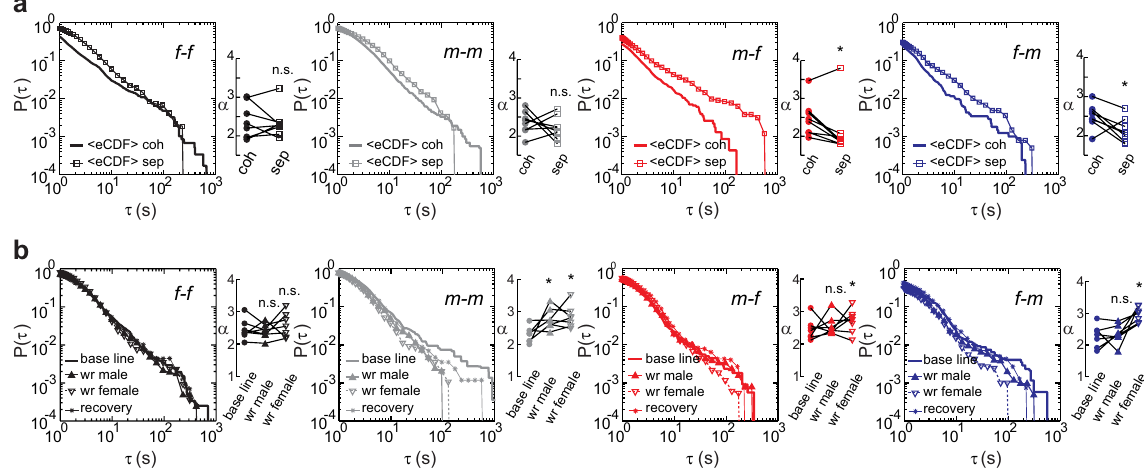
Figure 4. The exponents of different callings changed transiently in response to the social context ( a ) and the access to water ( b ). ( a ) Comparison of median empirical cumulative distribution functions ( < eCDF > ) between the inter-event intervals ( τ ) of “stack” calls during cohabitation (coh) and separation (sep). After limiting the social input to the auditory cues, the exponents ( α ) of reactive female (“ m-f ”) callings (p m-f = 0.039, n = 8) and reactive male (“ f-m ”) callings (p f-m = 0.027, n = 8) decreased while this did not change the exponents of self- contained female (“ f-f ”) and male (“ m-m ”) callings (p > 0.7, n = 8). ( b ) Comparison of < eCDFs > between the situations before, during and after removal of water. Removing water from males (wr male) increased the exponents ( α ) of self-contained male (“ m-m ”) callings (p m-m = 0.023, n = 7). Removing water from females (wr female) increased the exponents of self-contained male (“ m-m ”) callings (p m-m = 0.016, n = 7), of reactive female (“ m-f ”) callings (p m-f = 0.016, n = 7) and of reactive male (“ f-m ”) callings (p f-m = 0.008, n = 7). The other modes of callings remained unchanged (p > 0.050, n = 7). The exponents of base line and recovery were similar for all four modes of callings (p > 0.100, n = 7, recovery data are not shown on the ladder plots). n.s. and * indicate non-significant and significant, respectively. P( τ ): the cumulative distribution of the inter-event intervals; τ (s): the inter-event intervals in